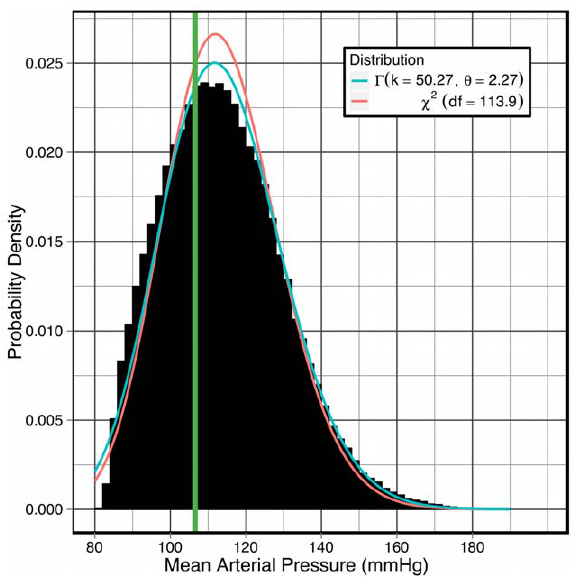
Figure 1. Probability density of mean arterial pressure (MAP) in the virtual population. The vertical line marks the threshold of hypertension ( MAP § 106 : 6 mmHg ), and both gamma and chi-squared distributions have been fitted. doi:10.1371/journal.pcbi.1002571.g001 MAP § 106 : 6 mmHg . Approximately one third of the virtual individuals were normotensive and two-thirds were hypertensive (see Table 4; using an older definition of hypertension (160/95) leads to 41% of virtual individuals being classified as hypertensive).